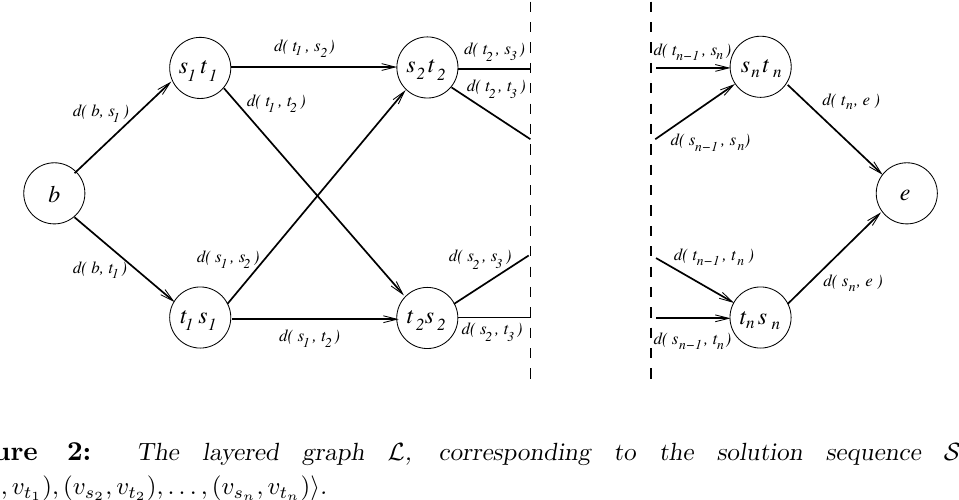
Figure 2: The layered graph L , corresponding to the solution sequence S